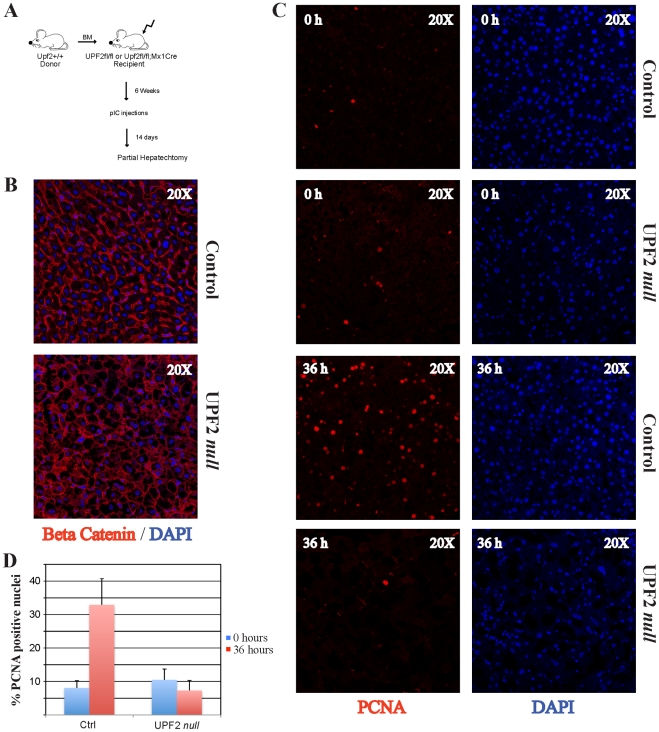
UPF2 is essential for liver regeneration.(A) Experimental strategy for the induction of UPF2 loss in the adult liver of BM transplanted control (Upf2fl/fl) and Upf2fl/fl; Mx1Cre mice followed by PH. (B) Immunofluorescence analysis of β-catenin of control and UPF2 null adult livers 14 days after the first pIC injection. (C) Immunofluorescence analysis of PCNA expression before (0 h) or after (36 h) PH. (D) Quantification of the data from (C), representing the average of three mice of each genotype at each time point. 200–500 nuclei were counted for each mouse at each time point (mean +/− standard deviation).